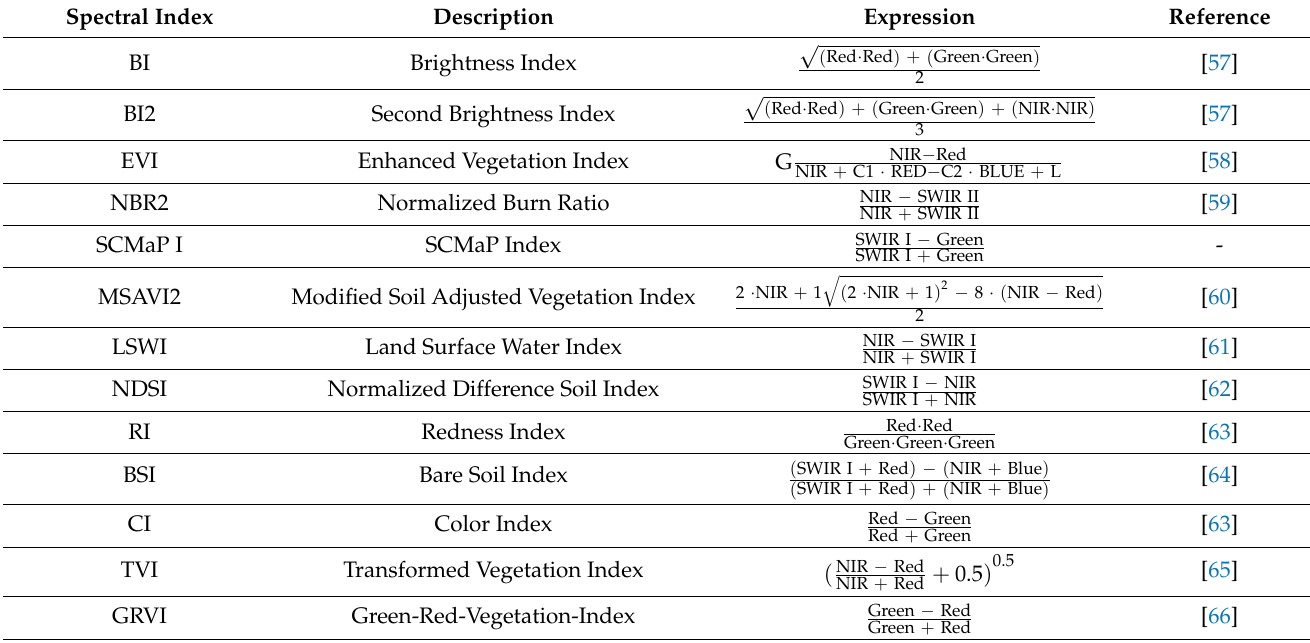
Table 2. Summary of the selected spectral